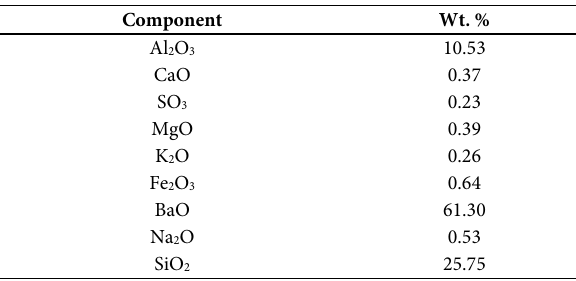
Table 2. Chemical composition of Y zeolite